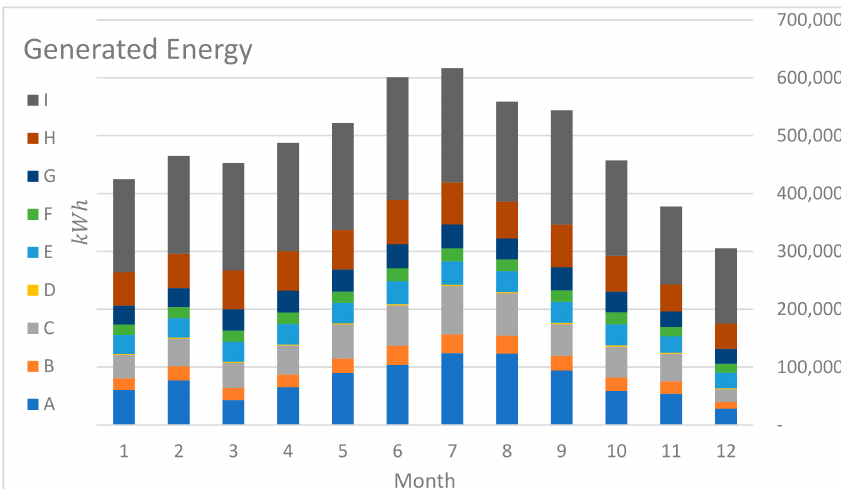
Figure 4. Generated energy of 9 DMUs.